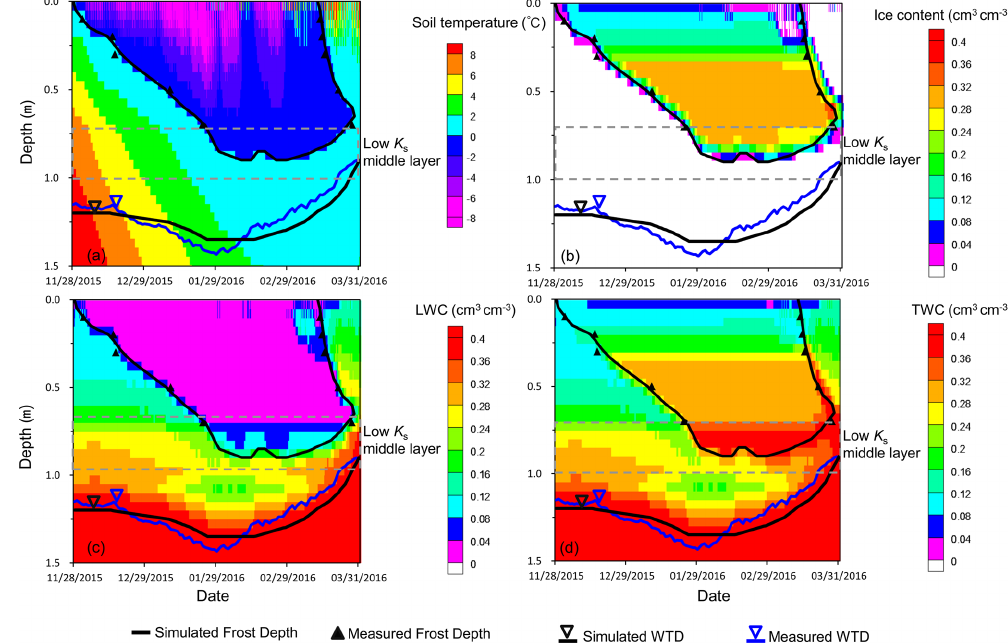
Figure 6. The evolutions of simulated soil temperature (a) , ice content (b) , liquid water content (LWC) (c) , and total water content (TWC) (d) at the field site. Also shown in the figures are evolutions of frost depth and groundwater